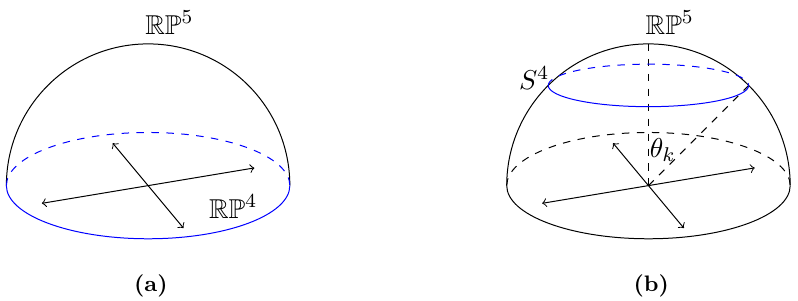
Figure 1. The real projective space RP 5 can be visualized as the upper hemisphere of S 5 with antipodal points on the equator identified. Since the neutral D5-brane dual to the spinor Wilson loop wraps an RP 4 submanifold of RP 5 , we can think of it as wrapping the equator, as is indicated by the blue curve in (a). Meanwhile, the D5-brane dual to the antisymmetric Wilson loop wraps an S 4 submanifold of RP 5 at polar angle θ k , as is indicated by the blue curve in